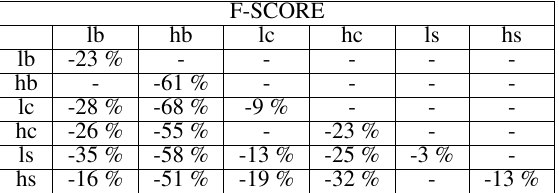
Table 4. F-score percentage values when using altered images in comparison to F-score values when using original, unaltered images